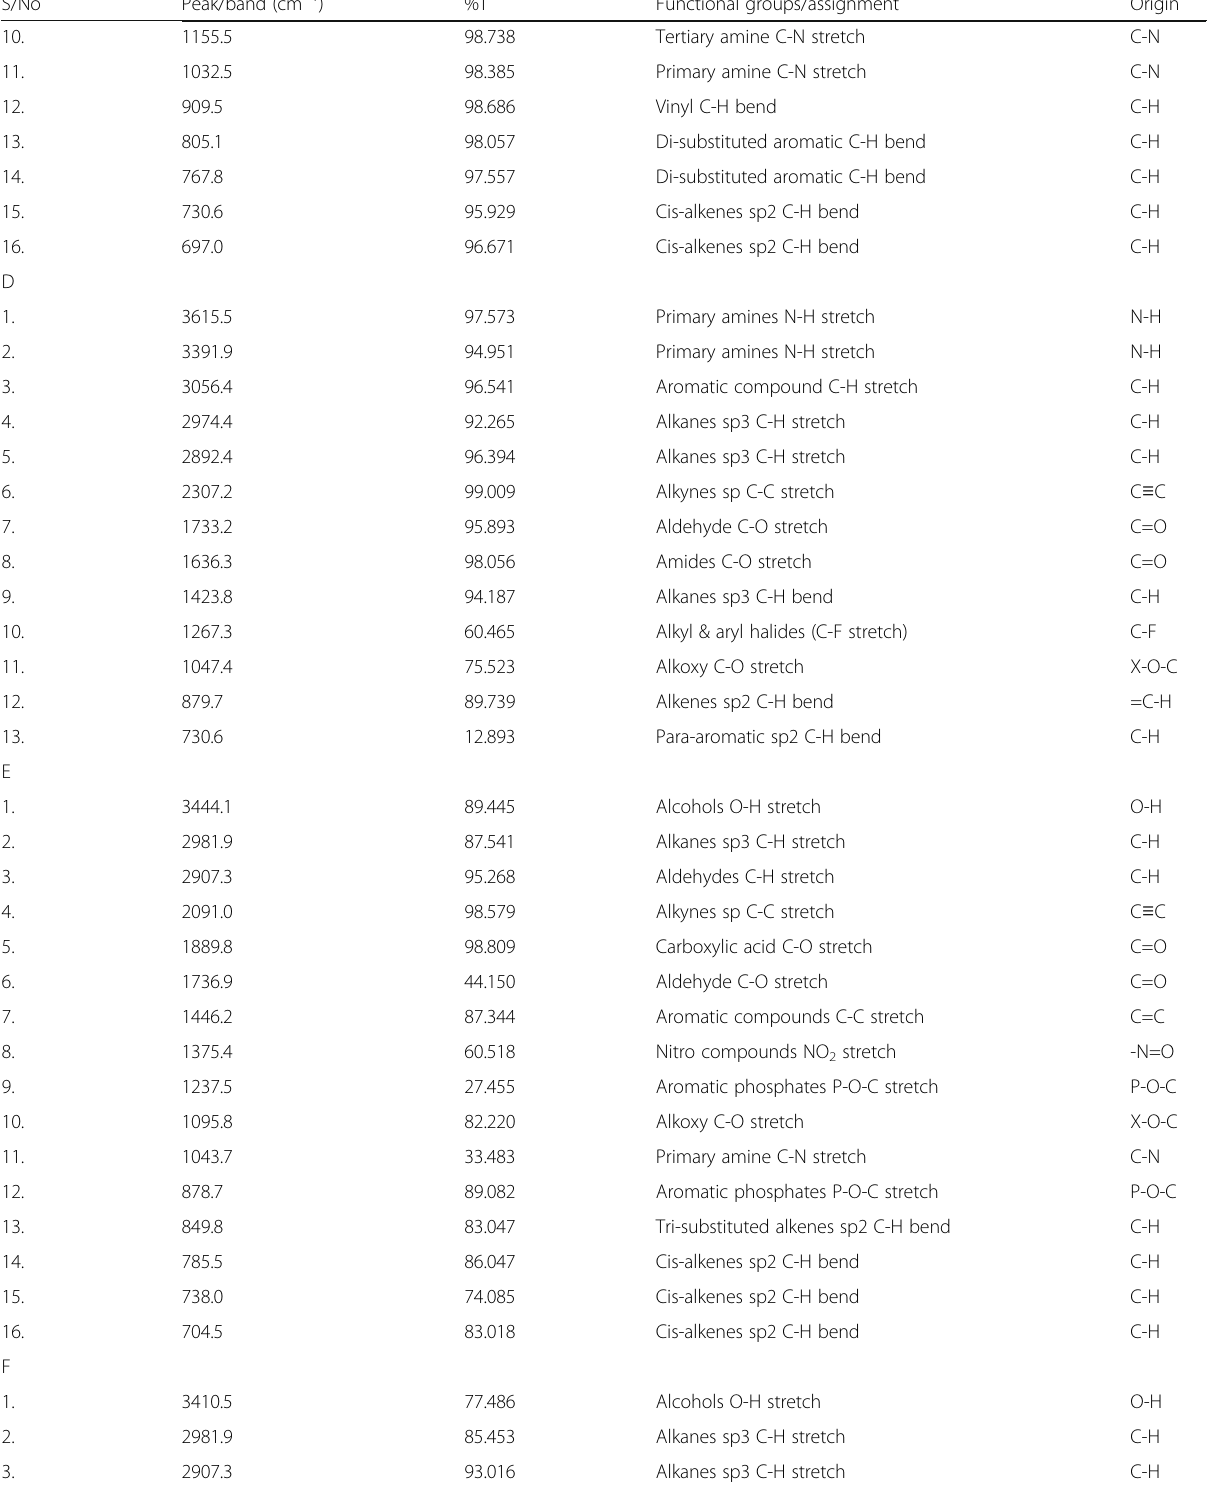
Table 5 FT-IR spectra peak values of (A) petroleum ether extract of A . occidentale , (B) ethylacetate extract of A . occidentale , (C) n - hexane extract of P . guajava , (D) chloroform extract of P . guajava , (E) ethylacetate extract of P . guajava , and (F) ethylacetate extract of T . catappa